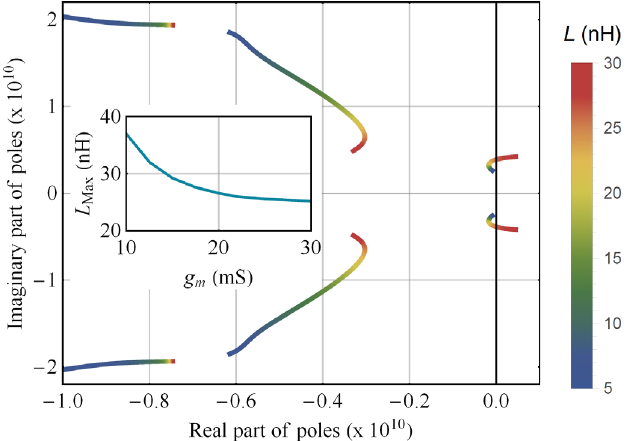
Fig. 12. Poles lociatnodeB. g m isconstant(22mS).Tocancelthe real part of Z Linv at 530MHz, R varies from 90 to 60 V when L goes from 5 to 30nH. The inset shows the evolution of L max with g m